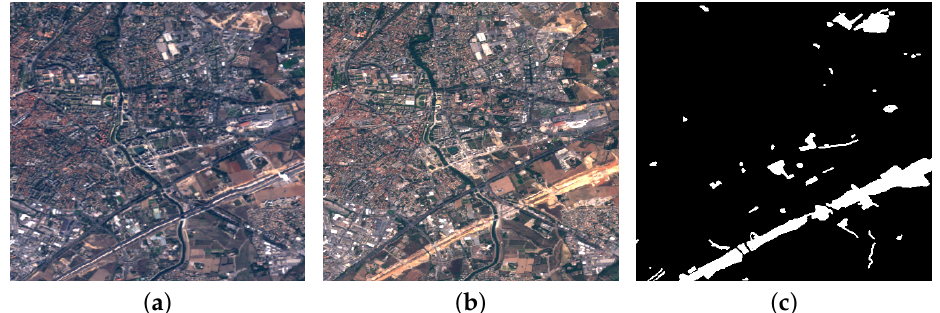
Figure 5. Montpellier of OSCD. ( a ) Pre-change. ( b ) Post-change. ( c ) ground truth map.